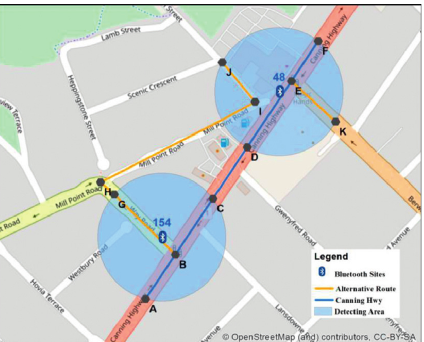
Figure 13: An alternative route of link 48-154 and 154-48.